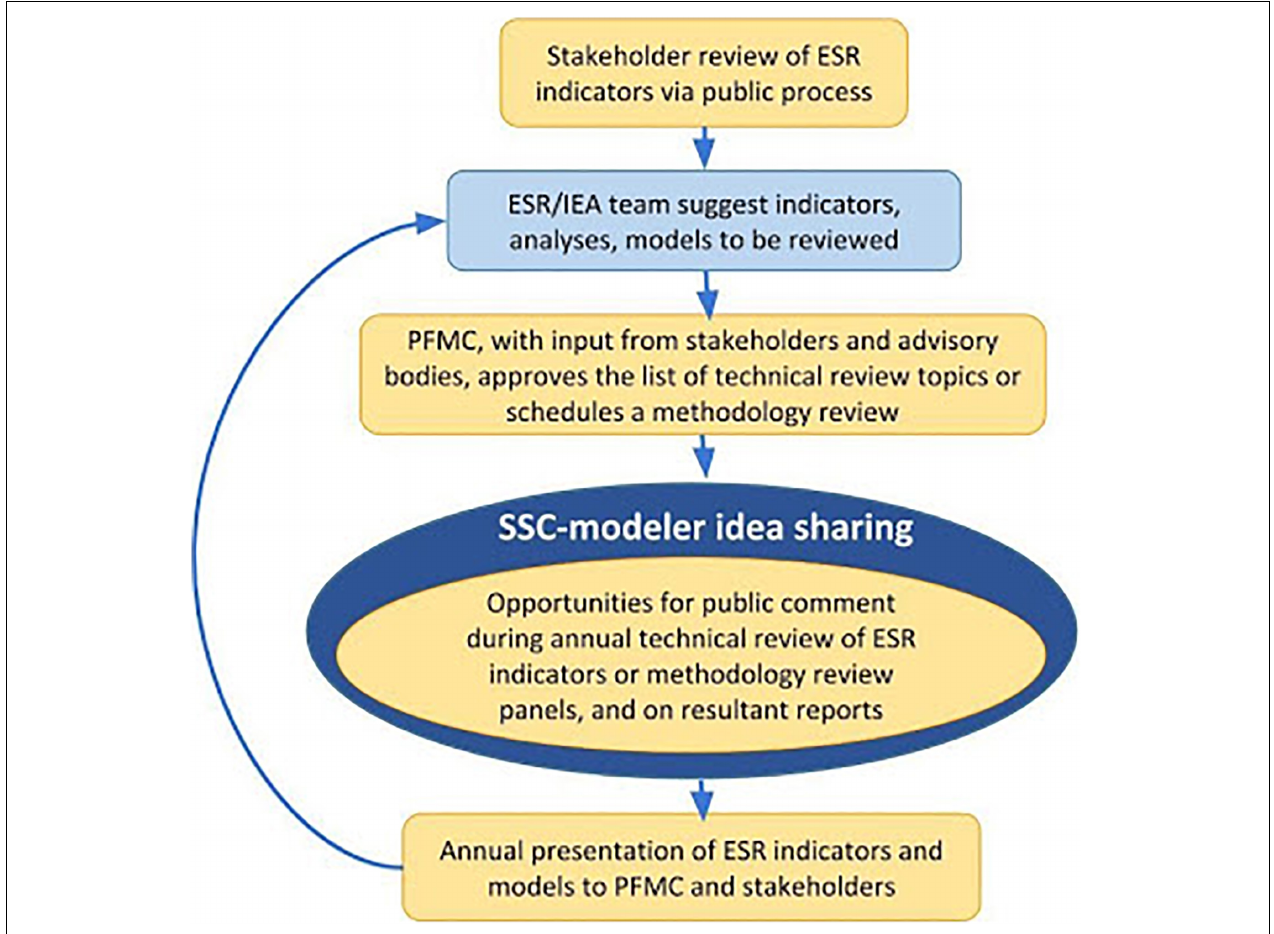
FIGURE 2 | Overview of opportunities for stakeholder feedback (orange boxes) on ESR indicators and ecosystem models and analyses in the PFMC management